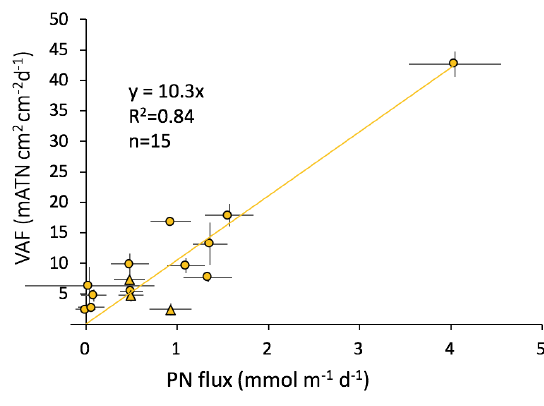
Figure 7. Regressions of volume attenuance flux